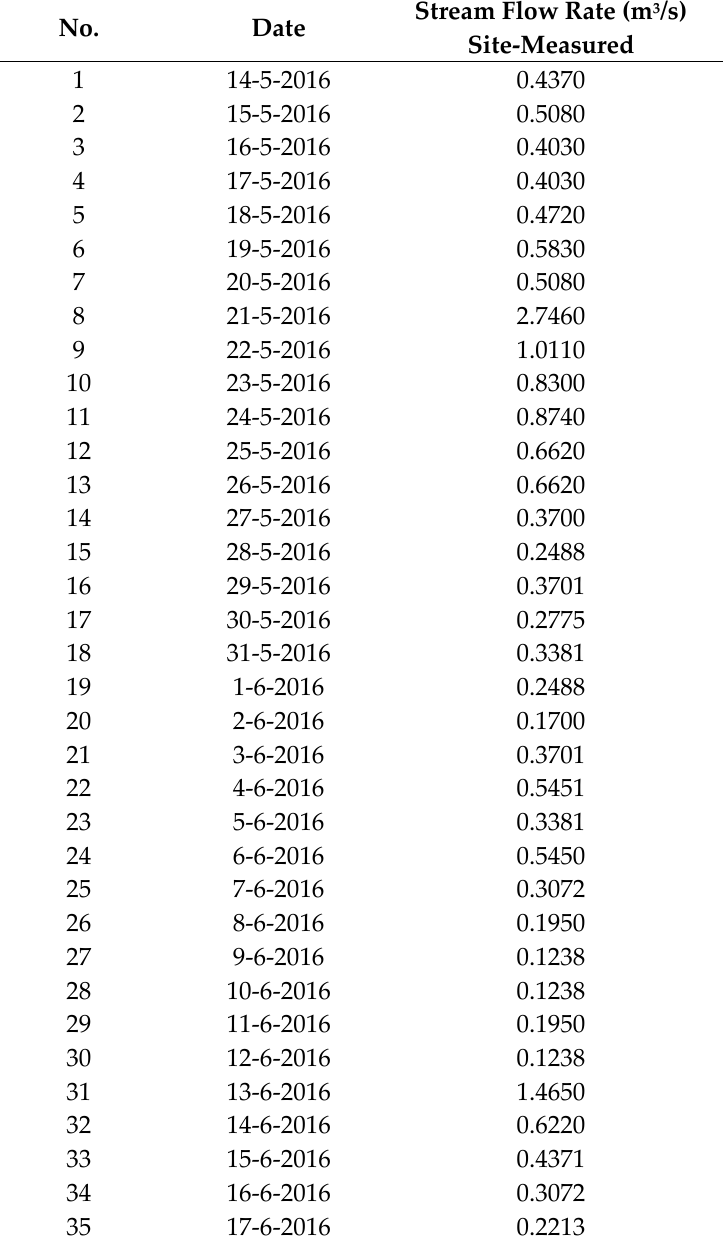
Table A1. Stream flow rate measurements of Perigiali